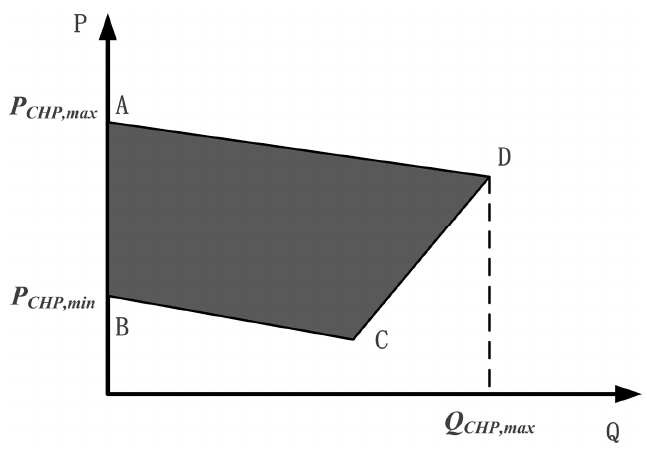
Figure 3. The heat ‐ power feasible operation region of a CHP unit. Figure 3. The heat-power feasible operation region of a CHP